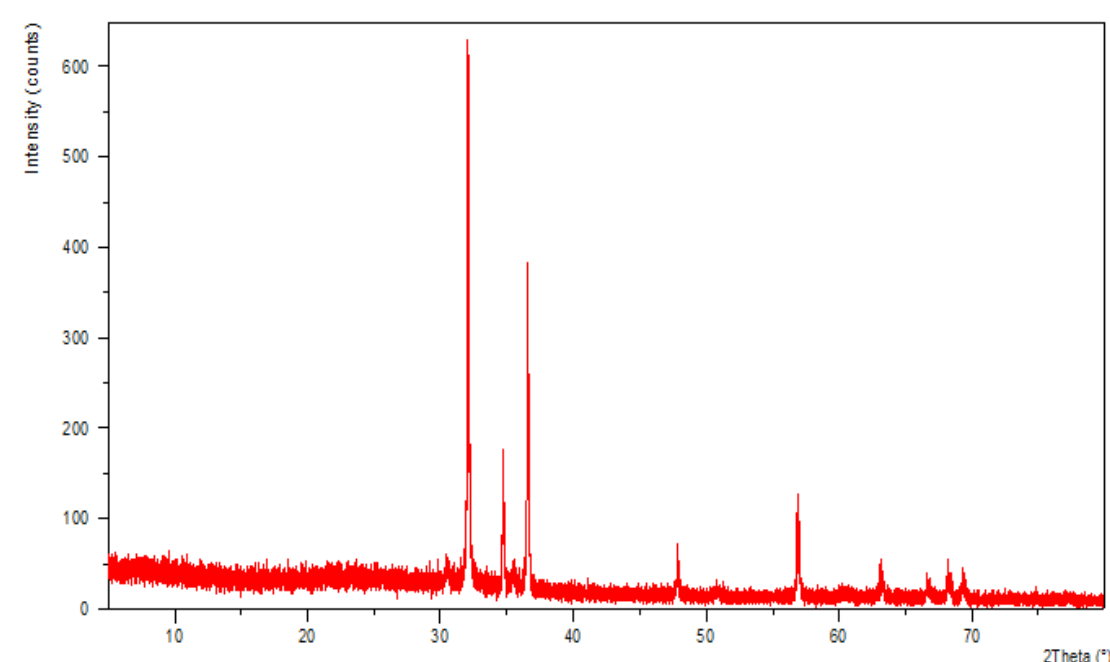
Figure 5. ZnO PXRD pattern at room temperature.